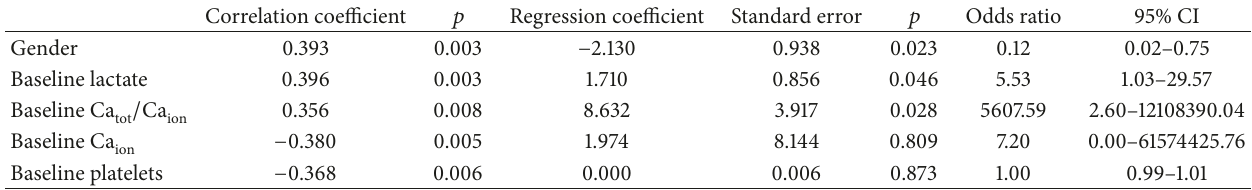
Table 5: Univariate analysis and multivariate analysis of predictors for citrate accumulation at 1 hour after ALSS therapy. Correlation